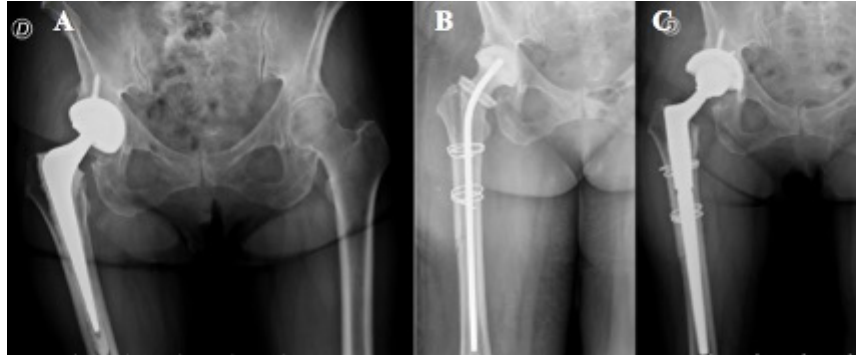
Figure 1. (a) Hybrid total hip replacement (THR) with demarcation around femoral stem. (b) Long antibiotic-impregnated cement spacer. (c) Femoral reconstruction with distal fixation stem 14 weeks after first-stage revision.